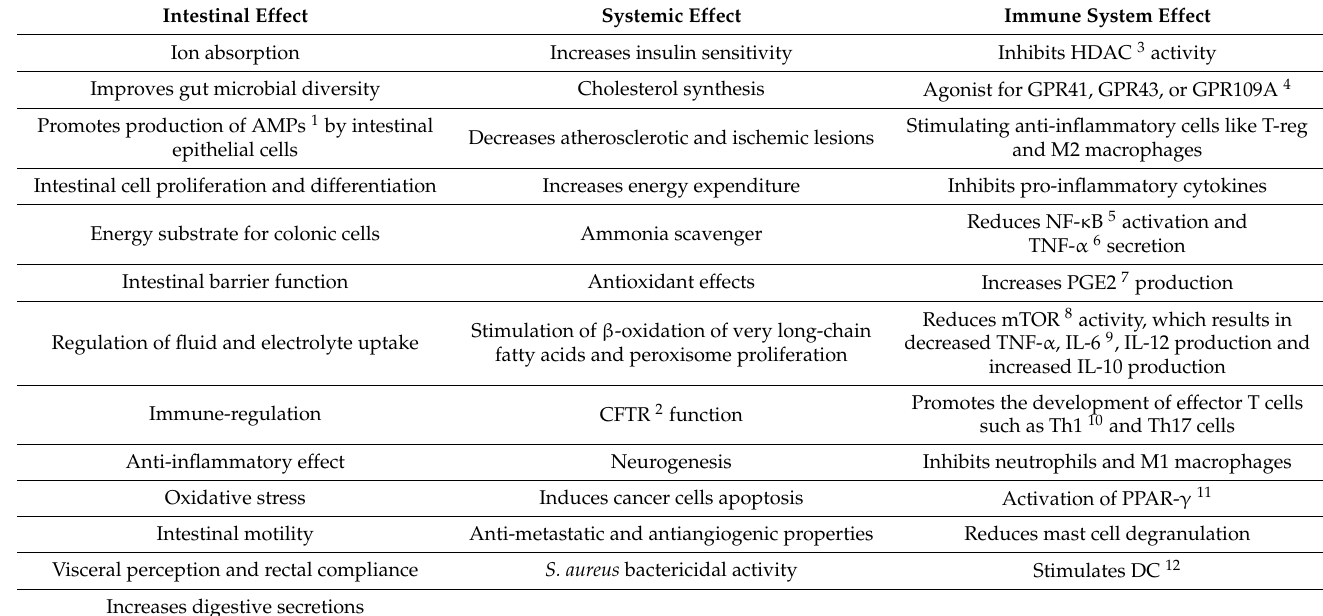
Table 1. Potential Effects of